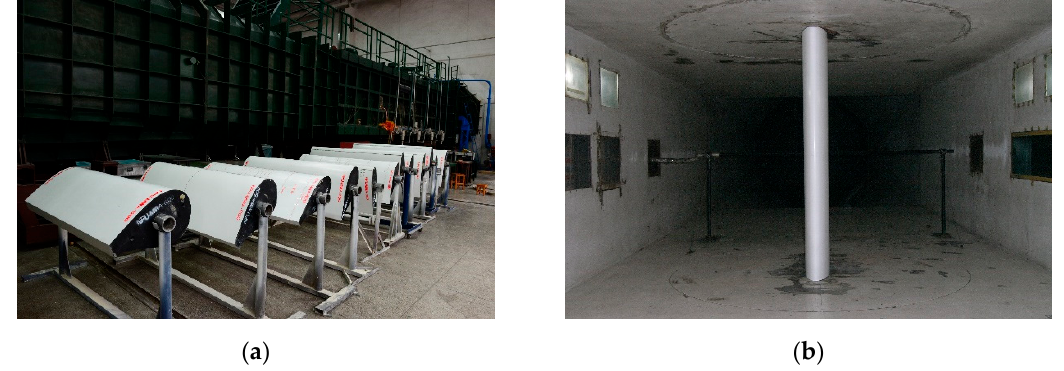
Figure 3. Experimental test of NPU-MWA wind turbine airfoils in the NF-3 low-speed wind tunnel of Northwestern Polytechnical University: ( a ) test models of NPU-MWA airfoils; ( b ) model in the test section of NF-3 wind tunnel.